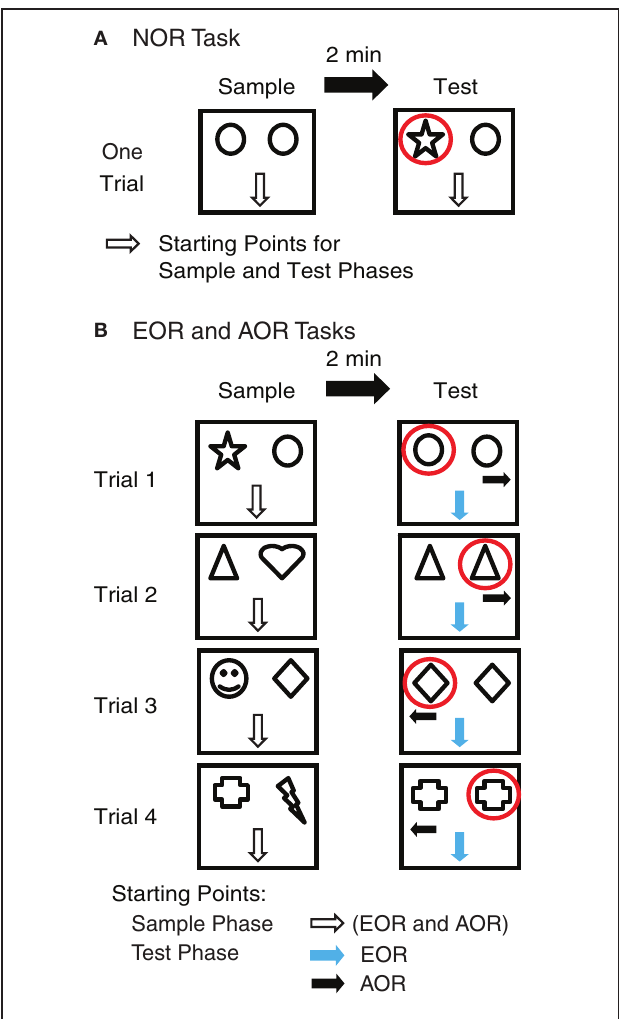
FIGURE 1 | Experimental paradigm. (A) In the novel object recognition (NOR) task, rats were first presented with two identical objects (sample phase, 5min, left), and returned to their home cage for 2min. During this period, one of the two objects was replaced with a novel object whose location (east or west) was varied randomly across subjects. During the test phase (right), the rats were allowed to explore the two objects for 5min. The rats’ starting positions in the sample and test phases were identical: facing the south wall. (B) In the egocentric (EOR) and allocentric (AOR) object-place recognition tasks, all aspects of the sample phase were identical: the rats were presented with two novel objects. As for the NOR task, they faced the south wall at the start of this sample phase. After a 5min exploration period, the rats were returned to their home cage for 2min. During this period, one object was replaced with an identical copy of the other. The position of this object duplicate was counterbalanced across trials. In the EOR task, the starting position of the rat was identical to that used in the sample phase (facing the south wall, blue arrow). In the AOR task, the rats’ starting position varied across trials (facing the east or west wall, black arrow). Four such trials were conducted, on four consecutive